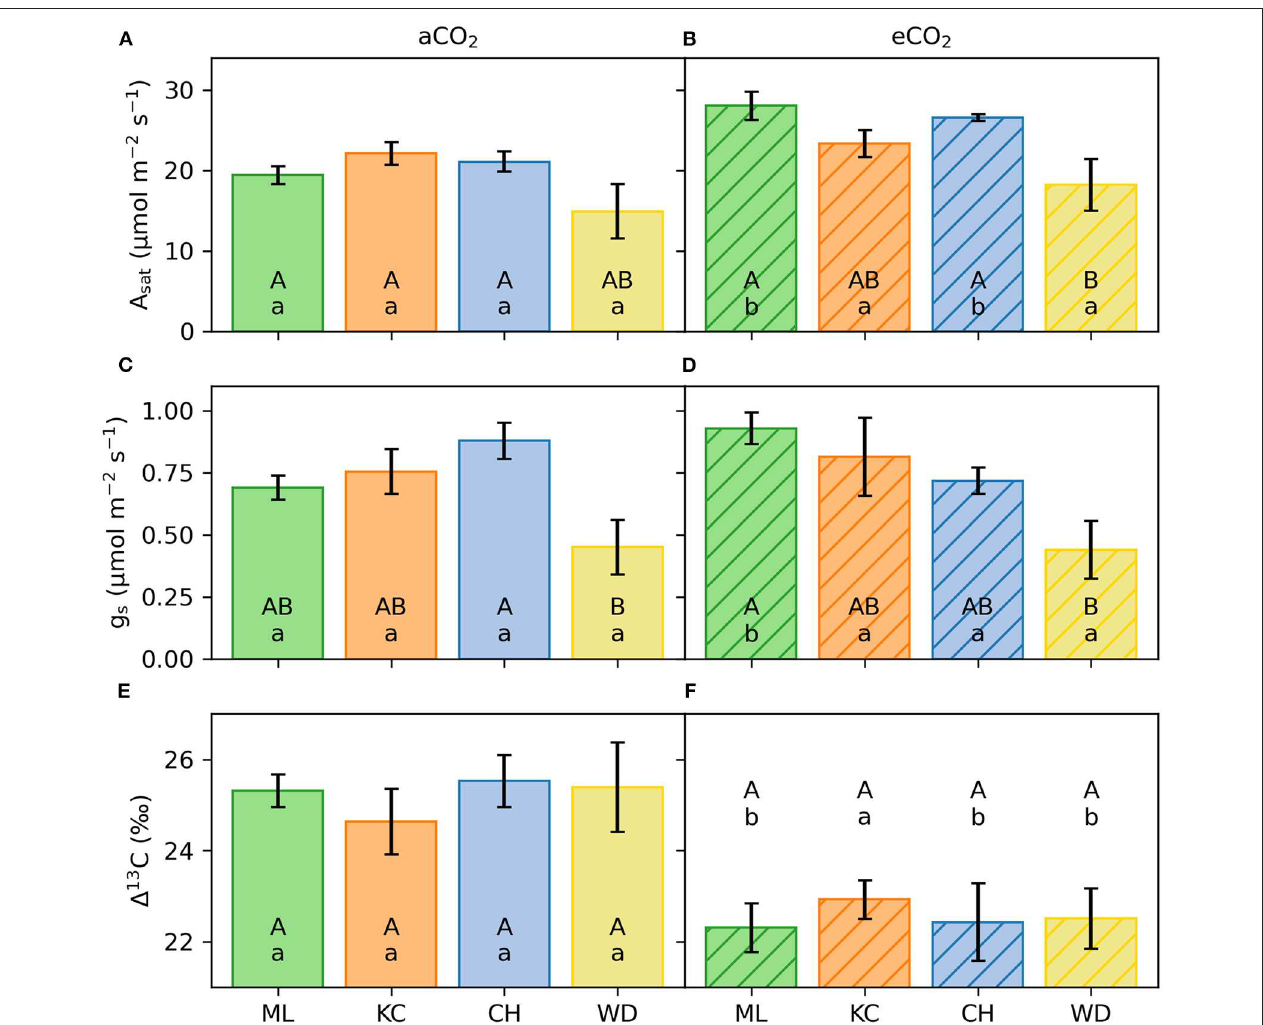
FIGURE 2 | Light-saturated photosynthesis ( A sat ; A , B ) stomatal conductance ( g s ; C , D ) and carbon isotope discrimination ( 1 13 C; E , F ) of four provenances of E. grandis selected for Experiment 1. Panels on the left show seedlings grown in ambient [CO 2 ] (aCO 2 ), panels on the right show seedlings grown in elevated [CO 2 ] (eCO 2 ; n = 5 per provenance). Error bars represent 1SE. Different capital case letters represent statistical significance of traits among provenances within the same [CO 2 ] treatment. Different lower-case letters represent statistical significance of traits between [CO 2 ] treatments per provenance.